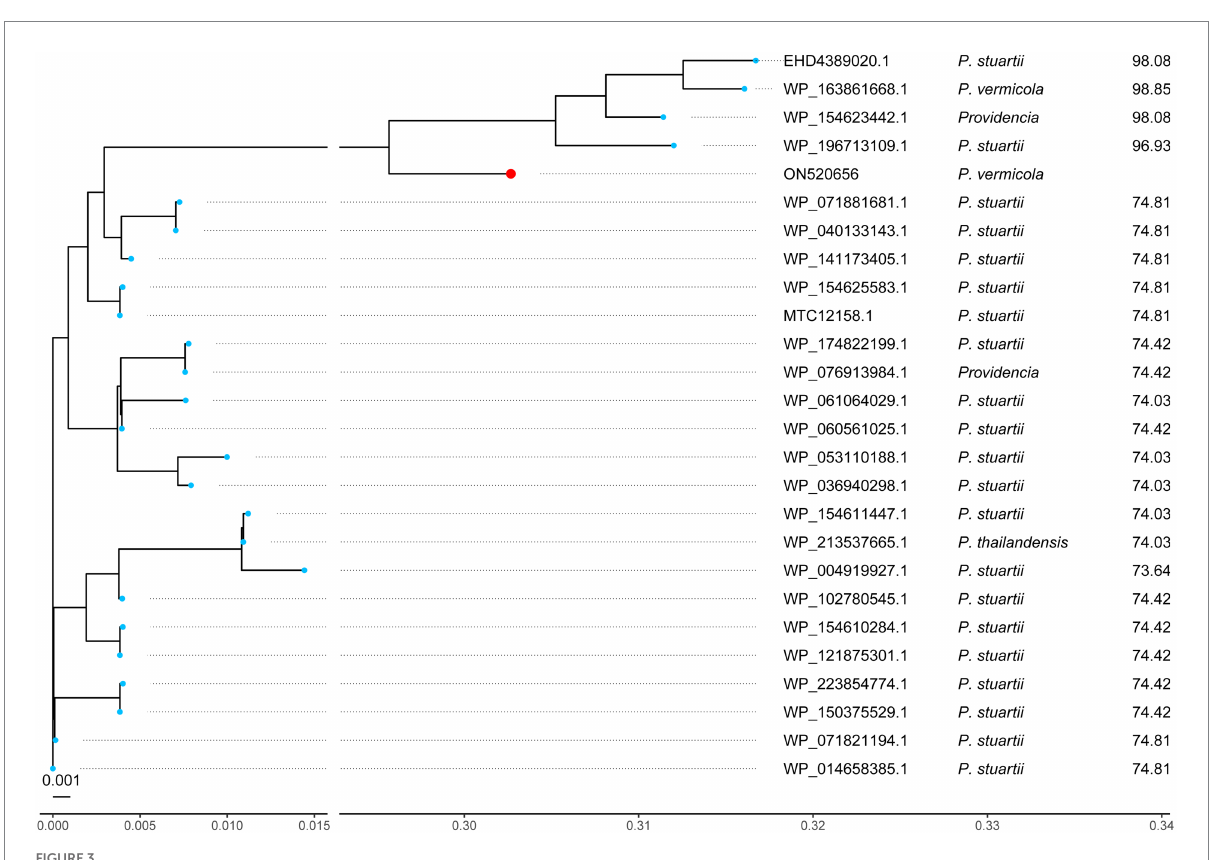
FIGURE 3 A phylogenetic tree showing the relationship of AadA33 with other putative ANTs. AadA33 is highlighted with a red dot. The three columns on the right represent accession numbers, the taxonomy of that sequence, and amino acid identity (%) with AadA33, respectively.